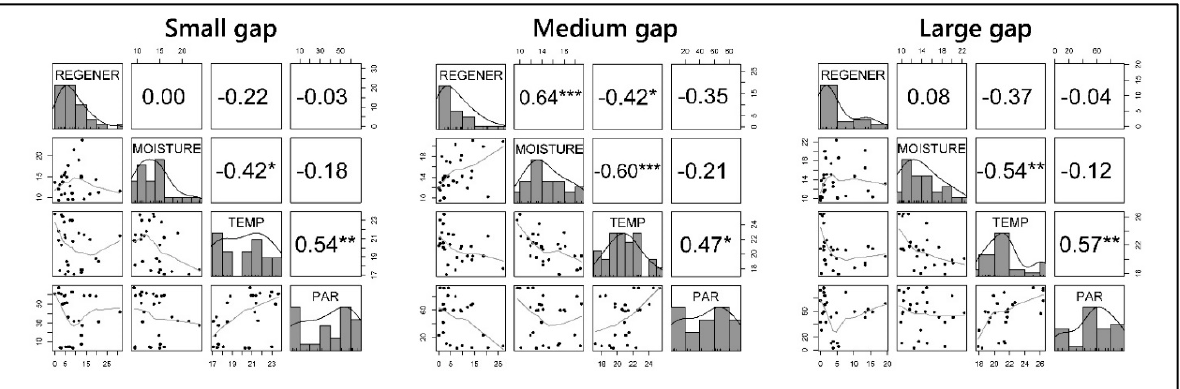
Figure 3. Scatterplot matrix with Pearson correlations. REGENER, natural regeneration; MOISTURE, soil moisture; TEMP, soil temperature; PAR, photosynthetically active radiation. For each gap size, n = 27. Asterisks stand for p -values: ***: p < 0.001; **: p < 0.01; * p < 0.05.